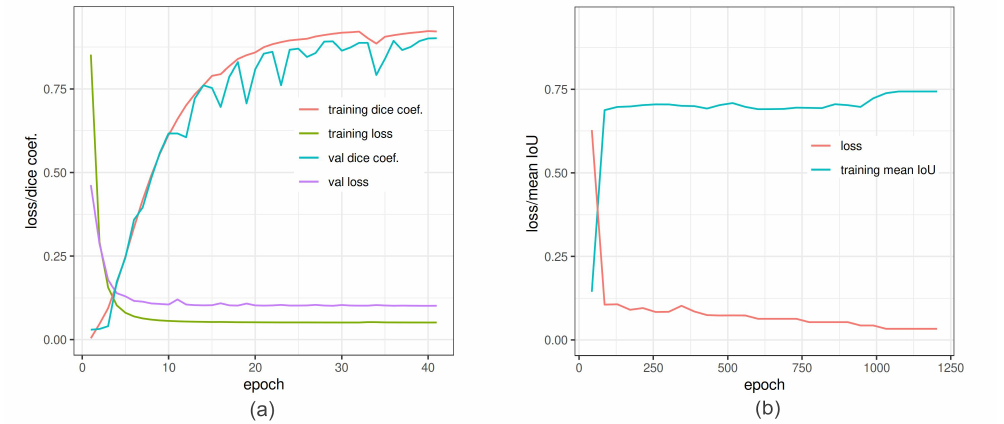
Figure 6. In-training accuracy of U-Net and DeepLabv3+ versus epochs: ( a ) Dice coefficient (red line) and binary cross-entropy (green line) reached pleateau around 35 epochs. The training was also validated by Dice coefficient (light sea-green line) and loss (purple line) to avoid overfitting. ( b ) Train- ing of DeepLabv3+ is depicted as function of mean IoU and net loss. The loss converge around 1200